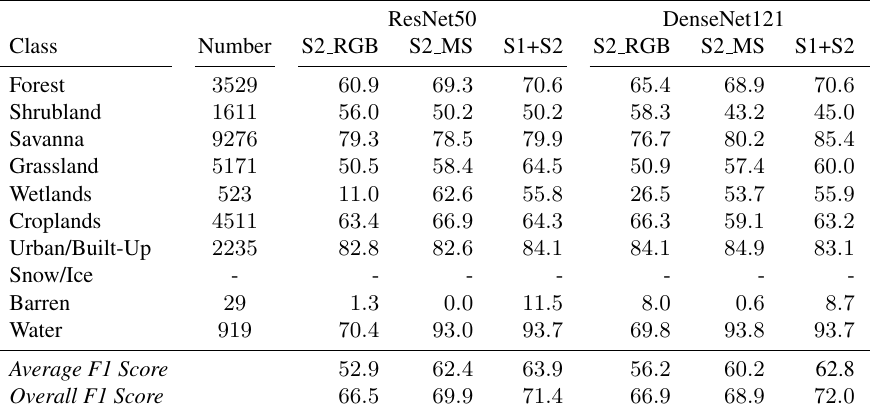
Figure 3: Multi-label predictions for three example patches using the S1+S2 input data configuration. The second example is partic- ularly noteworthy: While the reference denotes the patch as pure Savanna , the models add finer information by recognizing urban or cropland structures, respectively. Table 4: F1 scores for the different models in the multi-label